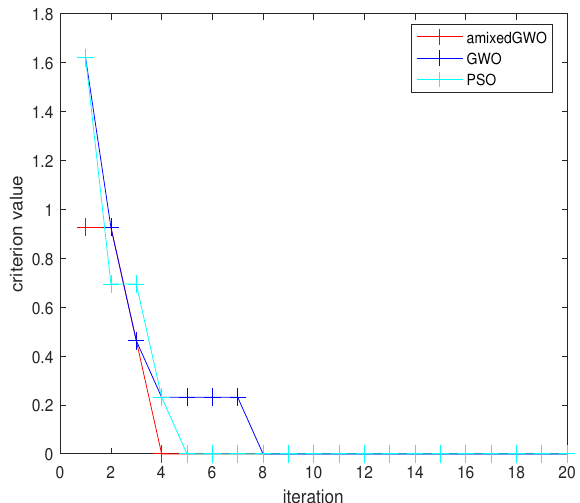
Figure 19. Convergence curve for amixedGWO, PSO and GWO: 16 original acquisitions, 144 images in